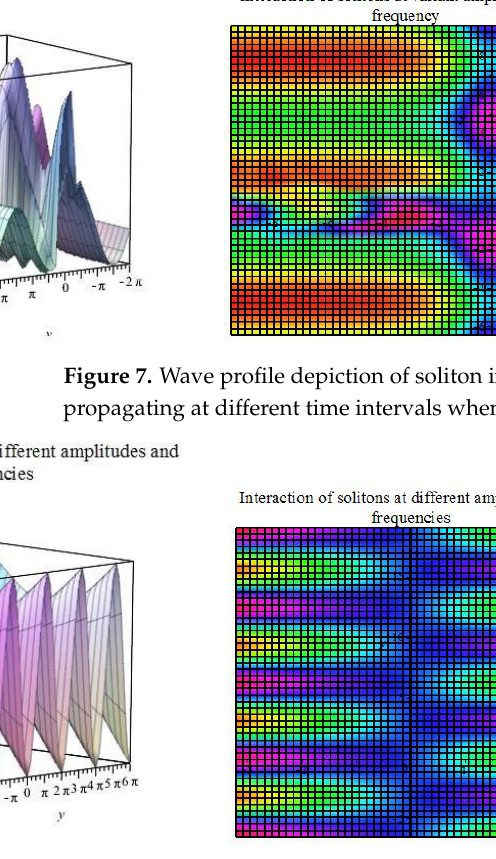
Figure 8. Wave profile depiction of soliton interaction with variant amplitudes and frequency with the propagation in the opposite directions when we have variable x = 0.